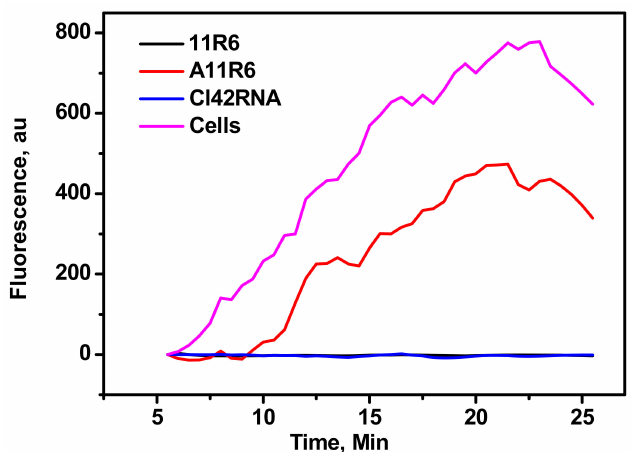
Figure 2. Bioluminescence assay: (Cl42RNA) overnight and the expressed luciferase enzyme was reacted with L-luciferin. Then, 4T1-Luc2 cells incubated with anti-VCAM-1 ssDNA full length (11R6), truncated aptamer (A11R6), or anti-IL4R α RNA aptamers. Changes in the bioluminescence intensities from the treated cells are plotted with